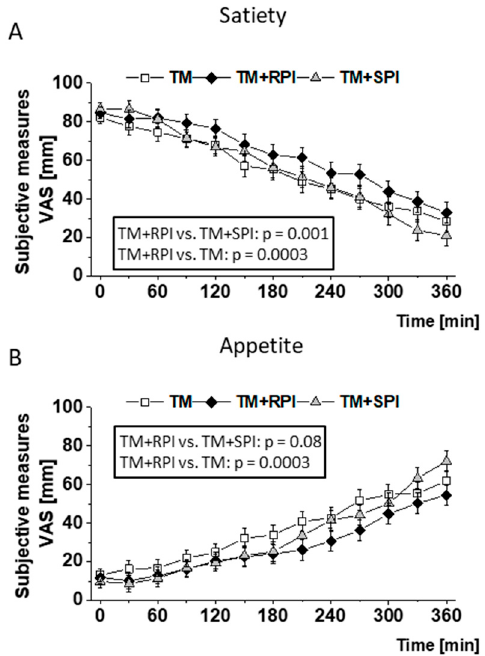
Figure 2. Postprandial satiety ( A ) and appetite ( B ) of study participants who received either the test meal (TM) without additional protein ( □ ), the TM with 28 g rapeseed protein isolate (RPI) ( ♦ ), or the TM with 28 g soy protein isolate (SPI) ( ▲ ). Satiety and appetite were assessed subjectively by using visual analog scales (VAS) in 30-min intervals. Differences in self-reported postprandial satiety and appetite were evaluated with a mixed model to test the effects of treatment, time, and their interaction (treatment × time) on each parameter. The value at baseline (before treatment) was considered a covariate. All p values were adjusted according to the Tukey–Kramer multiple group comparison procedure. For time-point analysis, the paired t-test was applied. Significance was accepted as p < 0.05. Data are presented as LSMs ± SEs ( n = 19).